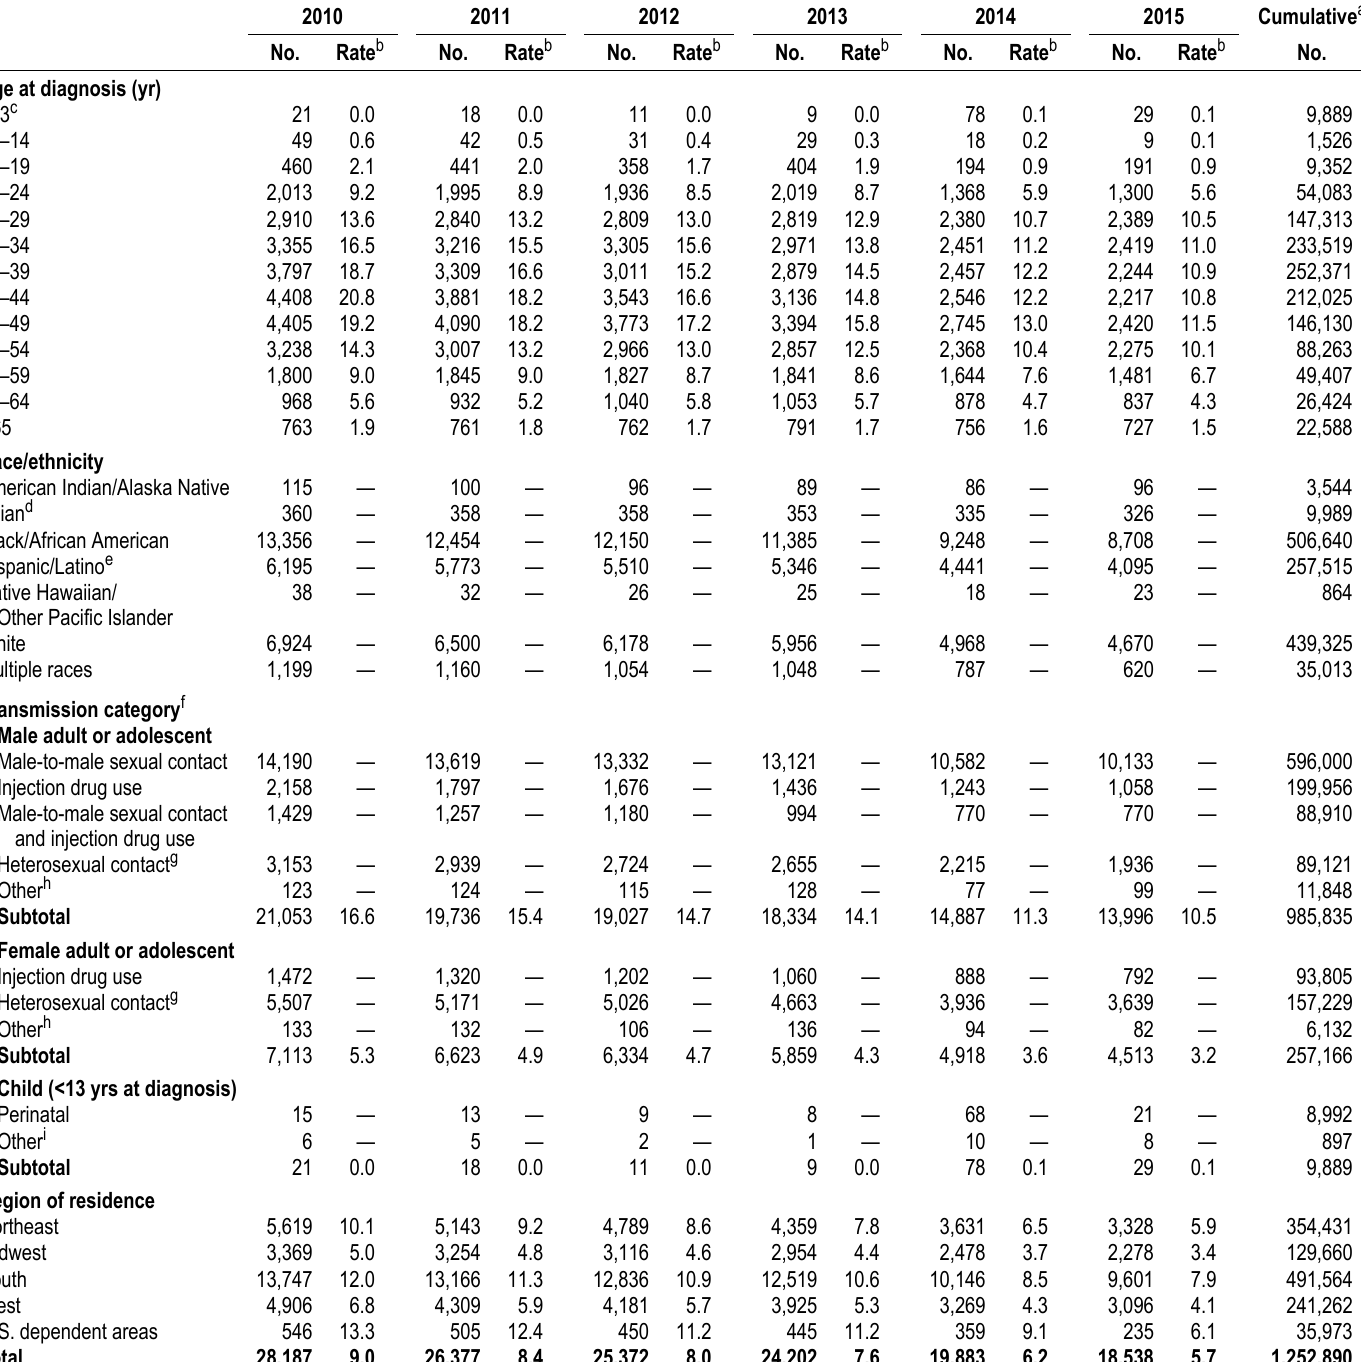
Table 2b. Stage 3 (AIDS), by year of diagnosis and selected characteristics, 2010–2015 and cumulative—United States and 6 dependent